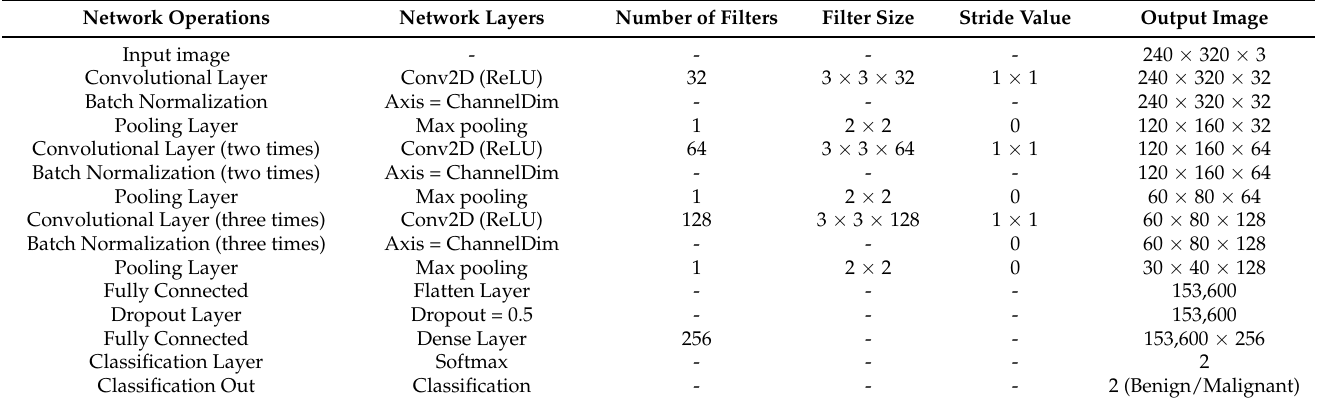
Table 3. The DCNN structure used for the